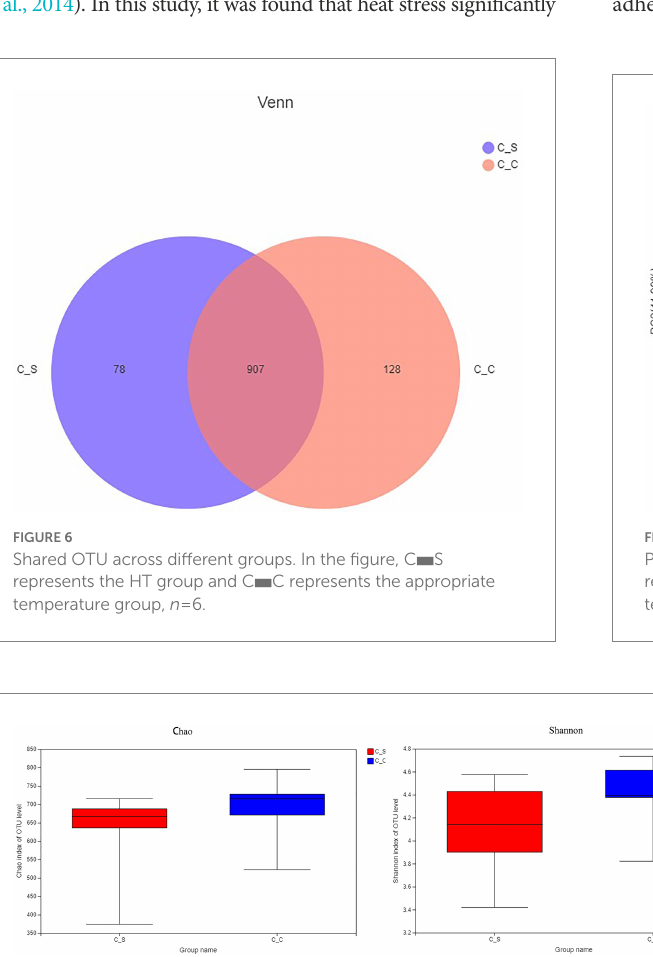
FIGURE 7 Alpha diversity.